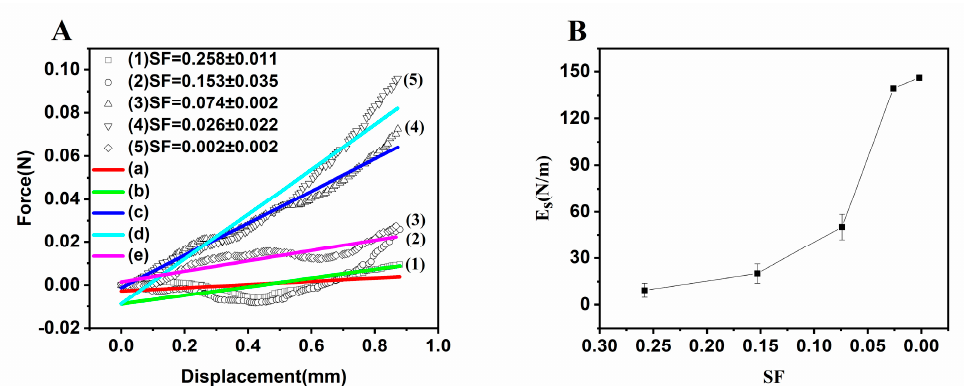
Figure 10. ( A ) Magnification of force–displacement curves of CaSA capsules filled with the different SF for linear regression and ( B ) surface Young’s modulus (E s ) calculation. The concentrations of CMC were 0.75 (a), 1.0 (b), 1.15 (c), 1.25 (d) and 1.5 (e) wt.%. The concentration of SA was 0.75 wt.%. The concentration of CaCl 2 was 1.5 wt.%.